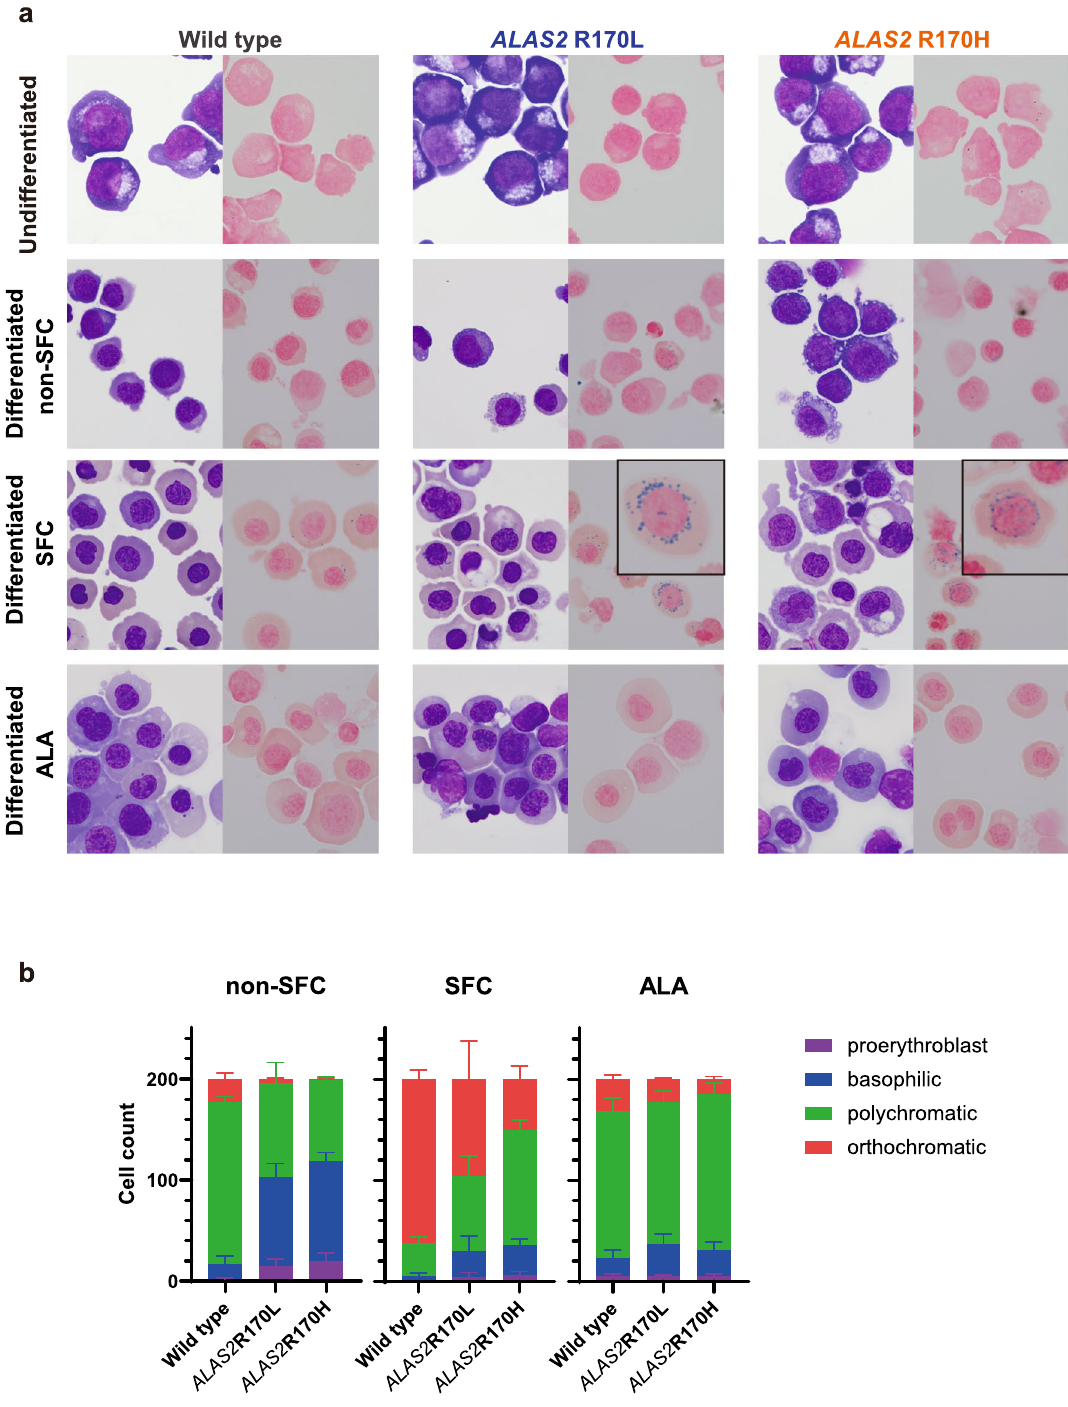
Figure 2. ALAS2 mutations result in impaired erythroid differentiation and ring sideroblast formation. ( a ) May-Giemsa (each of left panel) and Prussian blue staining (each of right panel) of HUDEP WT , HUDEP R170L , and HUDEP R170H . Ring sideroblasts are zoomed in the subpanels. The representative images of three independent experiments are shown. ( b ) Count of erythroid progenitor cells derived from HUDEP-2 clones after 6 day differentiation (n = 3). May-Giemsa staining was used for quantification. The graphs were plotted using GraphPad Prism 9 (GraphPad Software, San Diego, CA, www. graph pad. com). ALA, 5-aminolevulinic acid; SFC, sodium ferrous